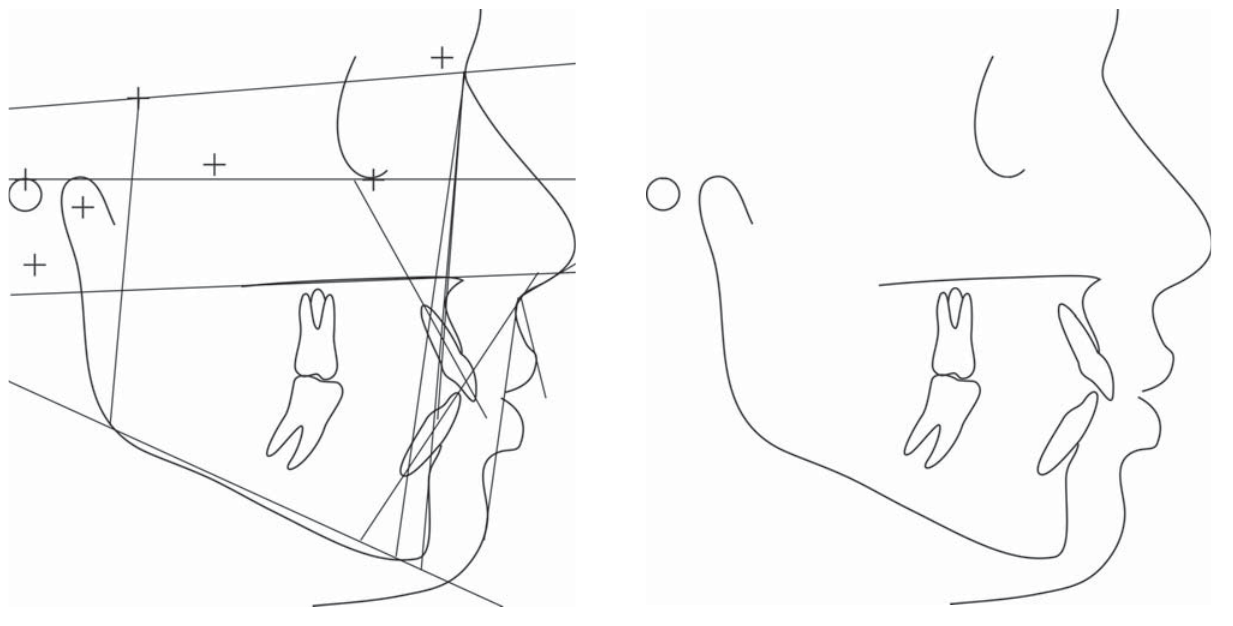
Figure 2- Lateral cephalogram with landmarks and measurements Table 1- Means and standard deviations (SD) of age and skeletal, dentoalveolar, soft-tissue and face height variables and results of t test for both groups